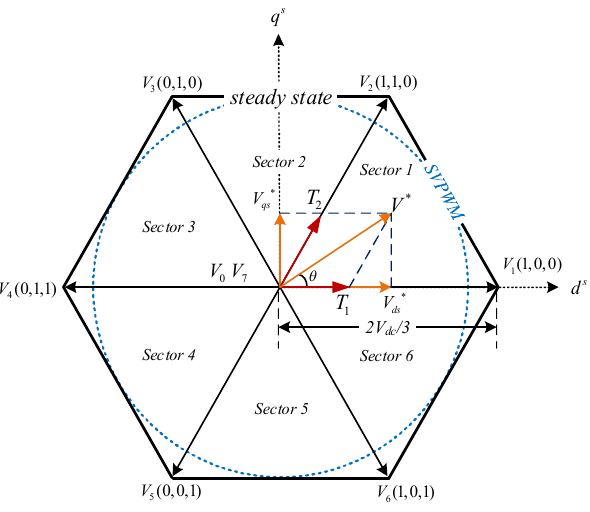
Figure 3. Space voltage vector diagram at steady state.